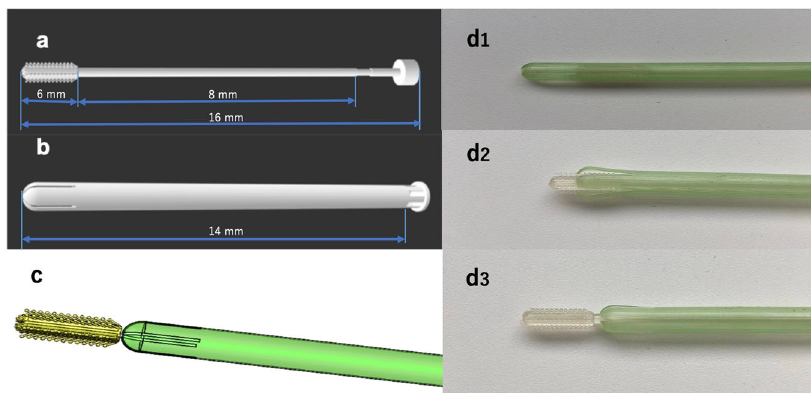
Fig. 2 Design of 3D-printed swab kits. a Side pro fi le of the swab and cover. b Combination of the cover and swab. c CAD image of the combination (cover and swab): d1 before extension; d2 during extension; d3 after complete